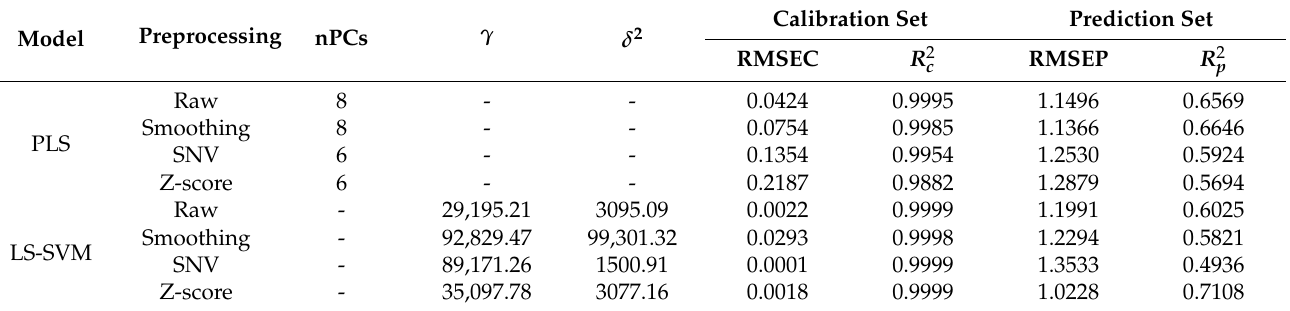
Table 2. Prediction parameters of PLS and LS-SVM with different preprocessing for the grating spectrograph